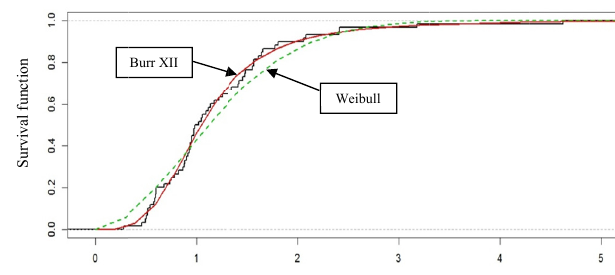
Fig. 2. Empirical function and the fitted functions for degree of splashing.